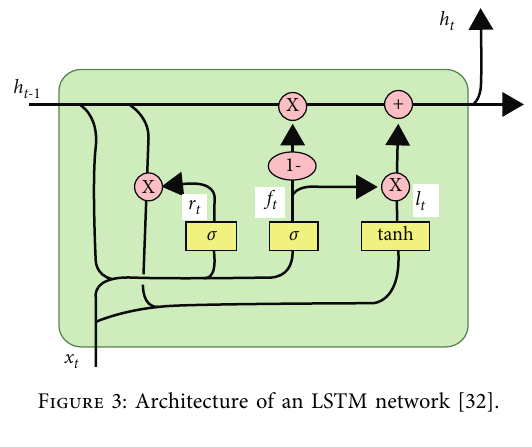
Figure 3: Architecture of an LSTM network